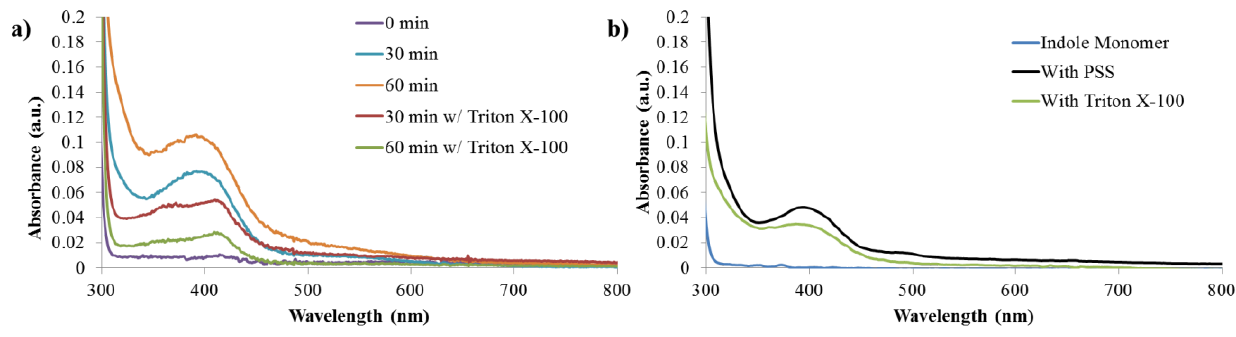
Figure 4. ( a ) Absorption spectra development during unbuffered polymerization reaction. ( b ) Comparison of absorption spectra of indole monomer and final products synthesized in a buffer in the presence of PSS and Triton